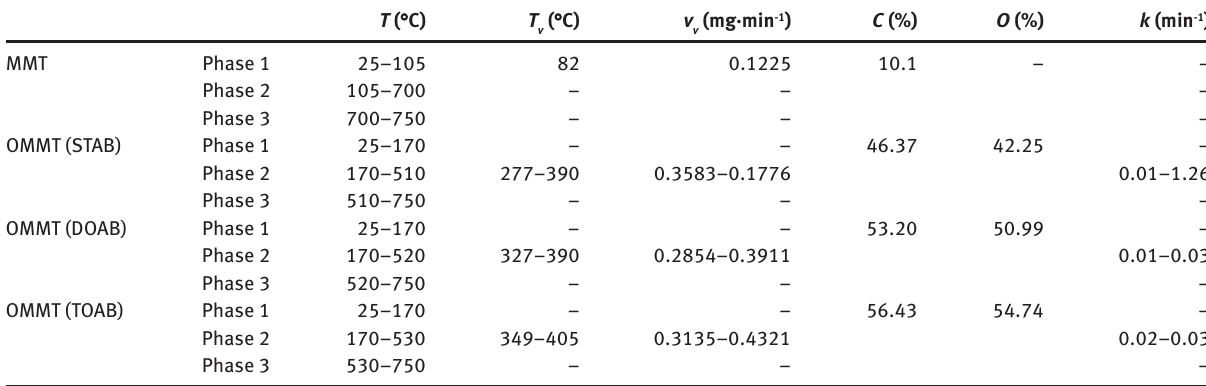
Table 3 Pyrolysis results of MMT and